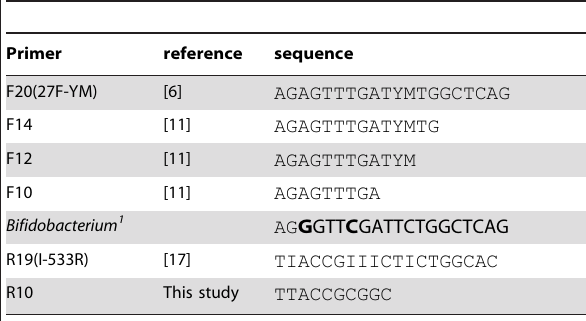
Table 2. The sequence of the region of the primers complementary to the 16S rRNA gene used in this